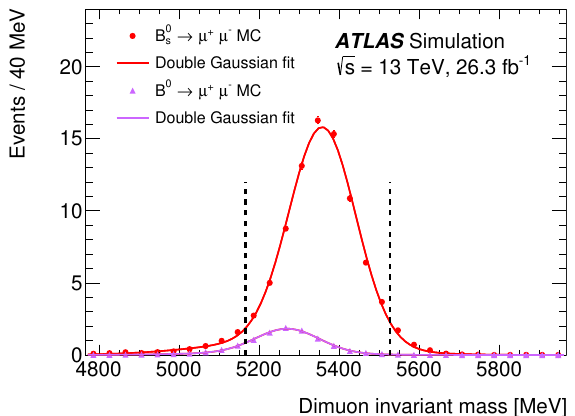
Figure 6. Dimuon invariant mass distribution for the B 0 results of the double-Gaussian (cid:12)ts are overlaid. The two distributions are normalised to the SM prediction for the expected yield with an integrated luminosity of 26.3 fb (cid:0) 1